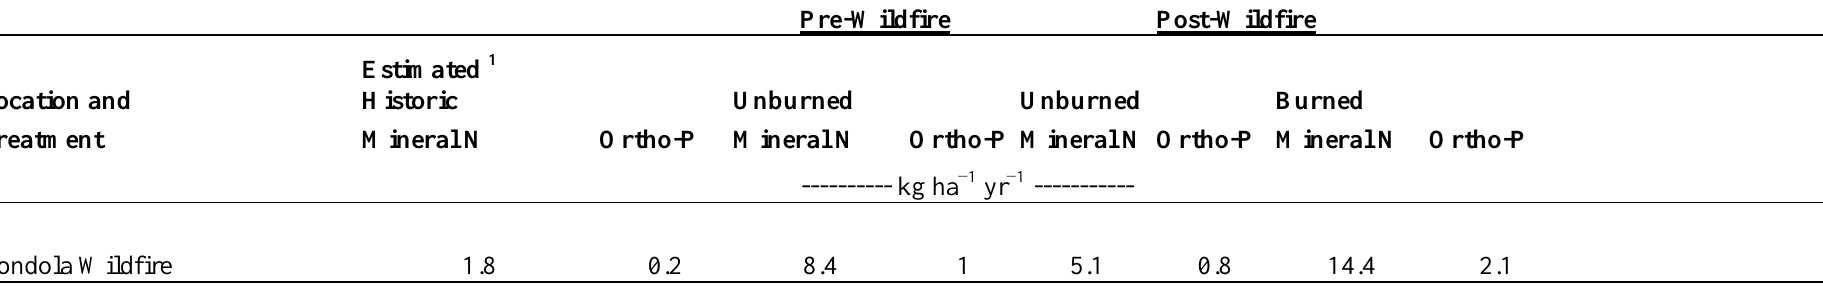
Table 5. Comparison of estimated historic overland/litter interflow runoff nutrient loading with current conditions and as affected by wildfire [22] and mechanical harvest/controlled fire